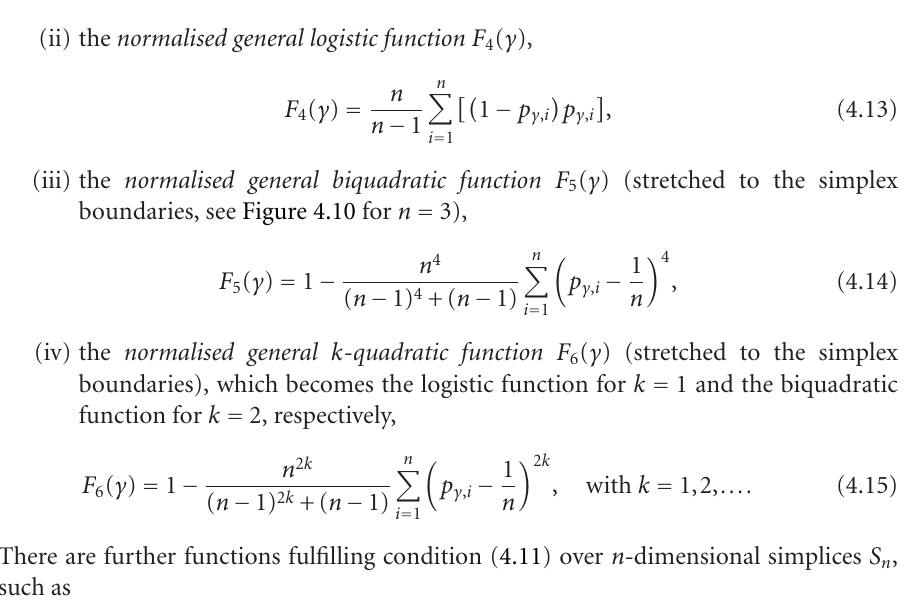
Figure 4.8. Normalised Shannon entropy F 2 ( γ ) for n = 3 defined on the simplex S 2 over triangular coordinates in the